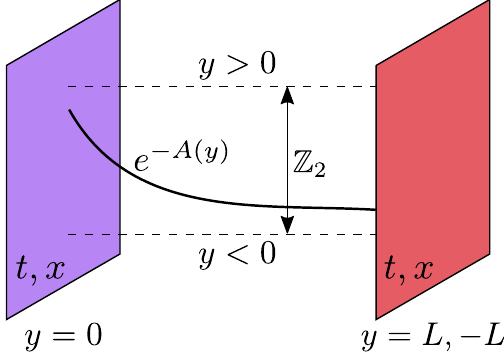
Figure 1. Schematic representation of the extra dimension in the Randall–Sundrum